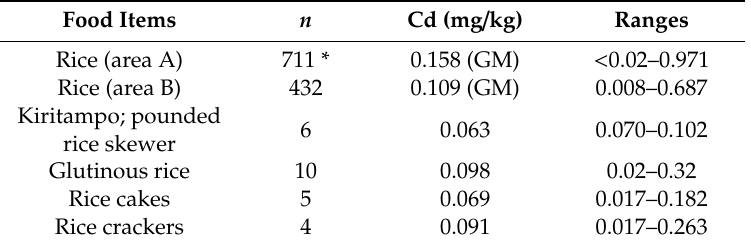
Table 1. Cadmium (Cd) concentrations in rice and rice products. Data are presented as arithmetic means, except for rice, which are presented as geometric means (GMs).